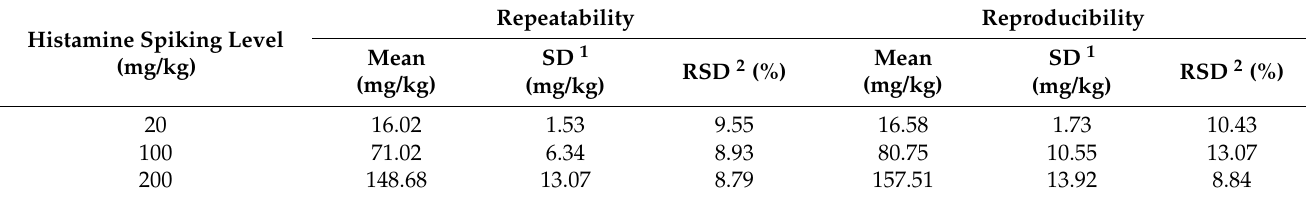
Table 3. Results of repeatability and reproducibility tests (expressed as RSD%) calculated for analysis of histamine in pet food.